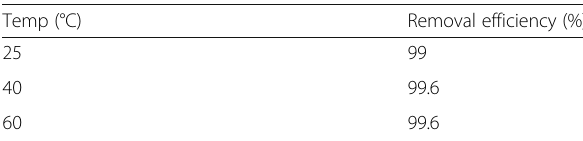
Table 4 Effect of temperature solution on MB removal